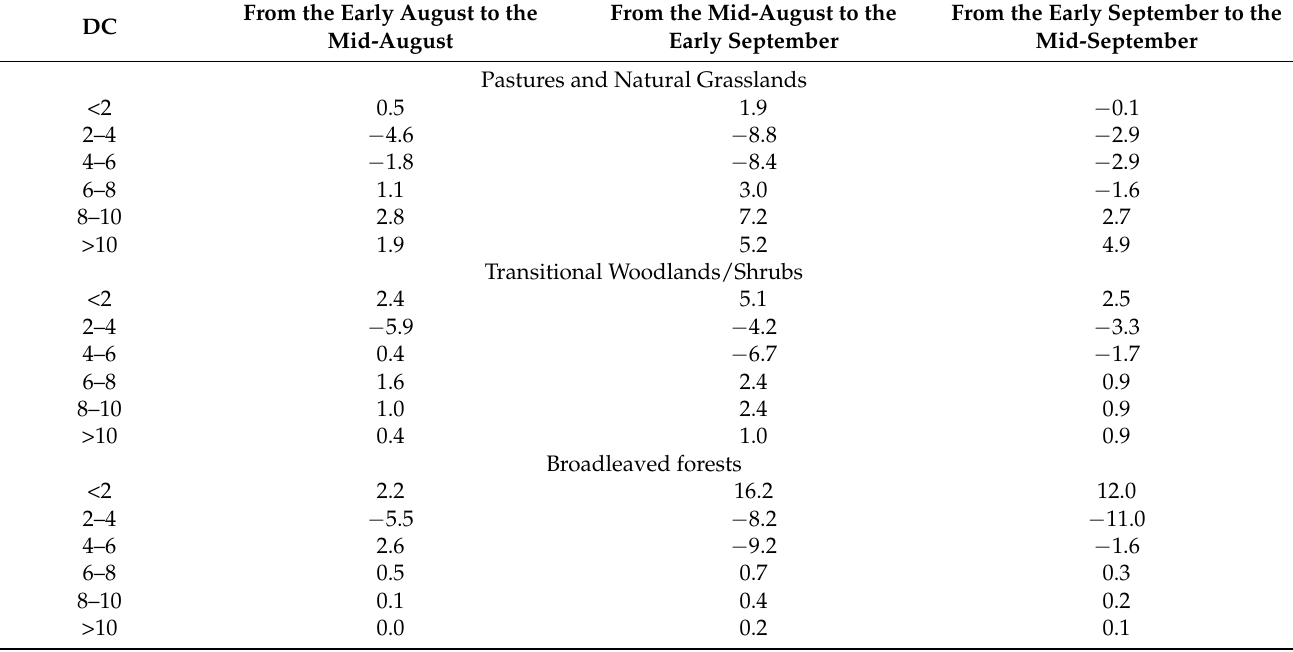
Table 5. Change in the area of the respective Drought coefficient (DC) by periods—in %.